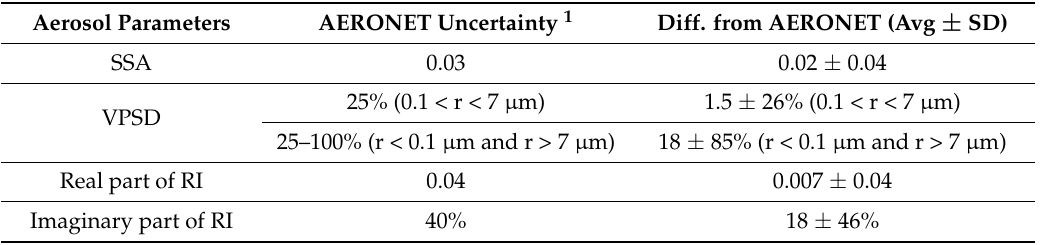
Table 1. Comparison of Single Scattering Albedo (SSA), Volume Particle Size Distribution (VPSD) and real and imaginary parts of refractive index (RI) from SONET and AERONET